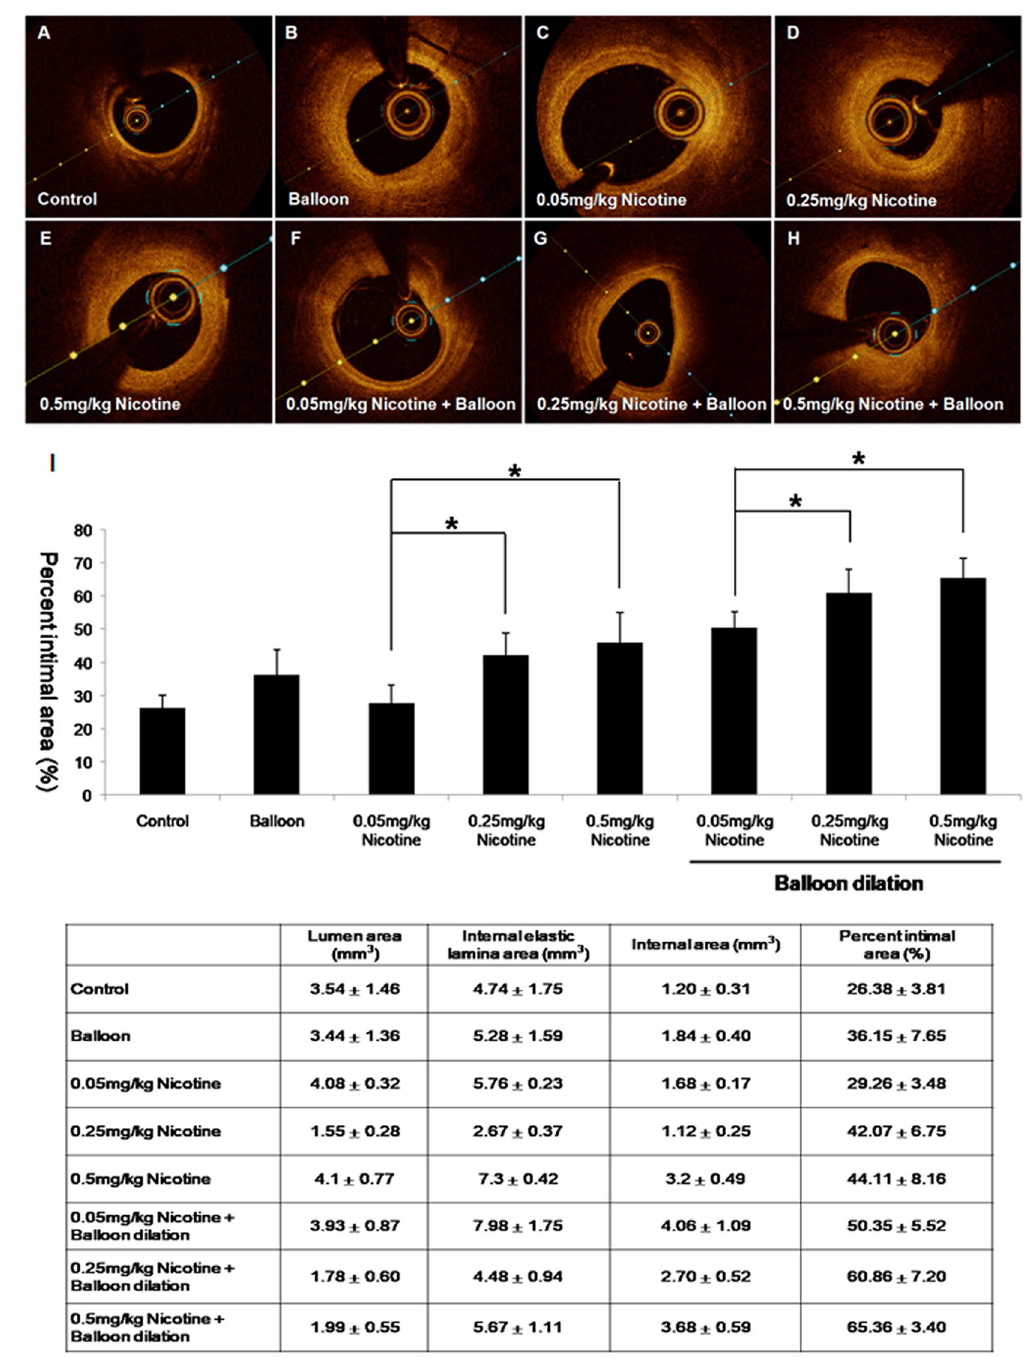
Figure 1. Intimal hyperplasia after balloon overdilation and nicotine injection in the coronary arteries. The control group showed thin and compact coronary artery wells ( A ). All treatment groups showed an increase of the percentage intimal hyperplasia in the OCT images ( B – H ). In the volumetric analysis of OCT, percentage intimal area significantly increased in the balloon overdilation group compared to the control groups (26.38 ± 3.81% in the control group vs 36.15 ± 7.65 in the balloon overdilation groups vs 29.26 ± 3.48 in the 0.05 mg/kg nicotine injection group). The percentage intimal area significantly increased in the 0.25 mg/kg and 0.5 mg/kg nicotine injection groups compared to the 0.05 mg/kg nicotine injection group (29.26 ± 3.48 in the 0.05 mg/kg nicotine injection group vs 42.07 ± 6.75 in the 0.25 mg/kg nicotine injection group vs 44.11 ± 8.16 in the 0.5 mg/kg nicotine injection group). The percentage intima area significantly increased in the 0.25 mg/ kg nicotine with balloon overdilation and 0.5 mg/kg nicotine with balloon overdilation groups compared to the 0.05 mg/kg nicotine injection with balloon overdilation group (50.6 ± 5.52 in the 0.05 mg/kg nicotine injection with balloon overdilation vs 60.86 ± 7.2 in the 0.25 mg/kg nicotine injection with balloon overdilation vs 65.36 ± 3.40 in the 0.5 mg/kg nicotine injection with balloon overdilation groups; p < 0.05) ( I